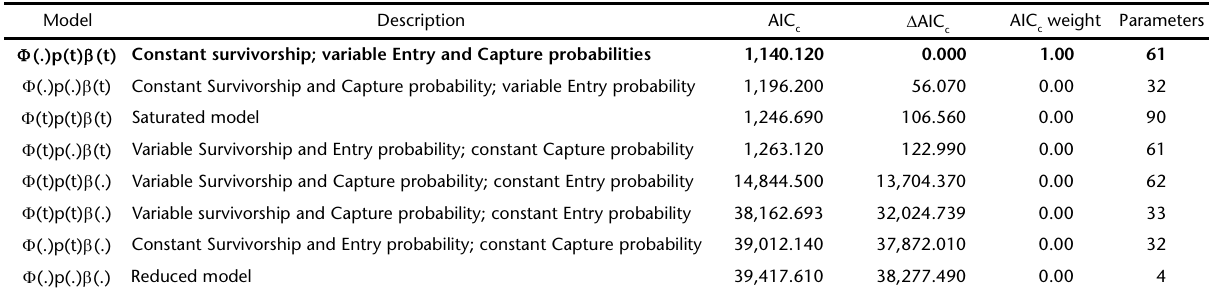
Table 1. Results of mark – recapture model selection of Megalobulimus paranaguensis in the Parque Zoobotânico Orquidário Municipal de Santos (PZOMS). The values of the most parsimonious model are in bold.